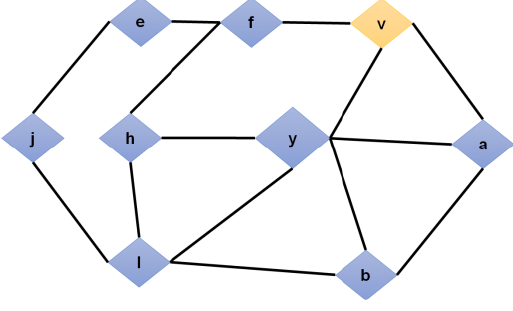
Figure 3. Node attack with no conflicts .